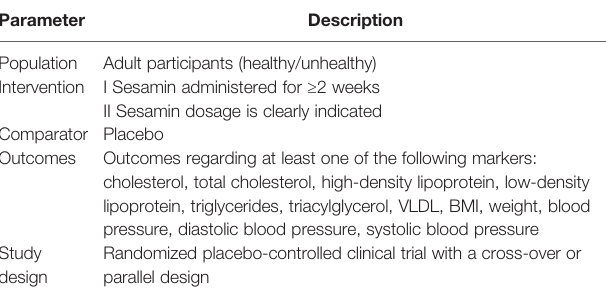
TABLE 1 | PICOS criteria for inclusion of studies. Parameter